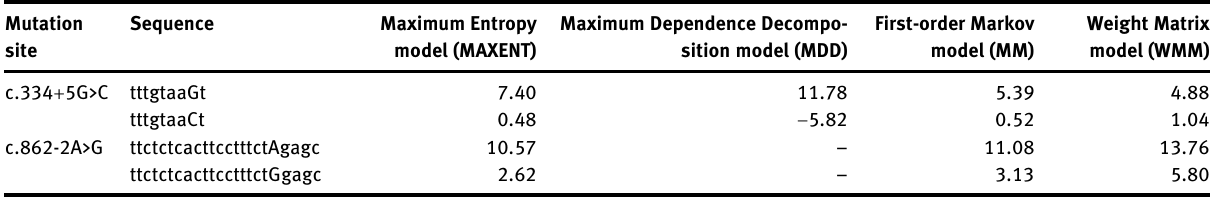
Table  : MaxEntScan prediction for c.  +  G>C and c.  -  A>G. Mutation